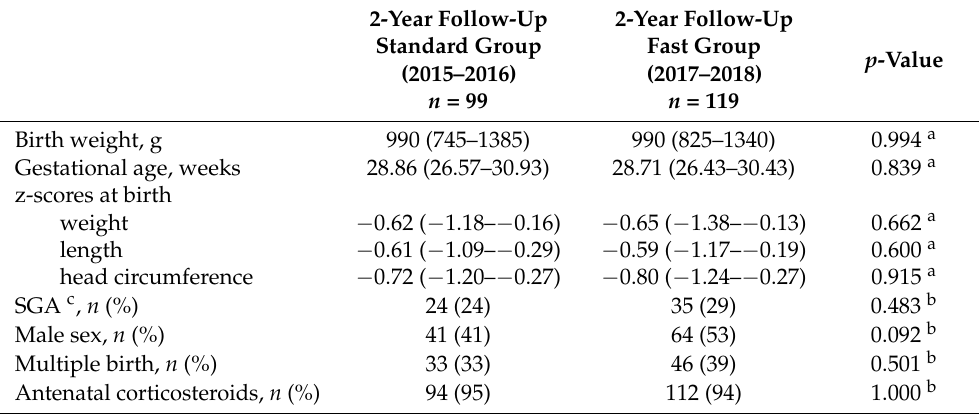
Table 1. Demographics and infant characteristics of the STENA cohort study followed-up at 24 months.